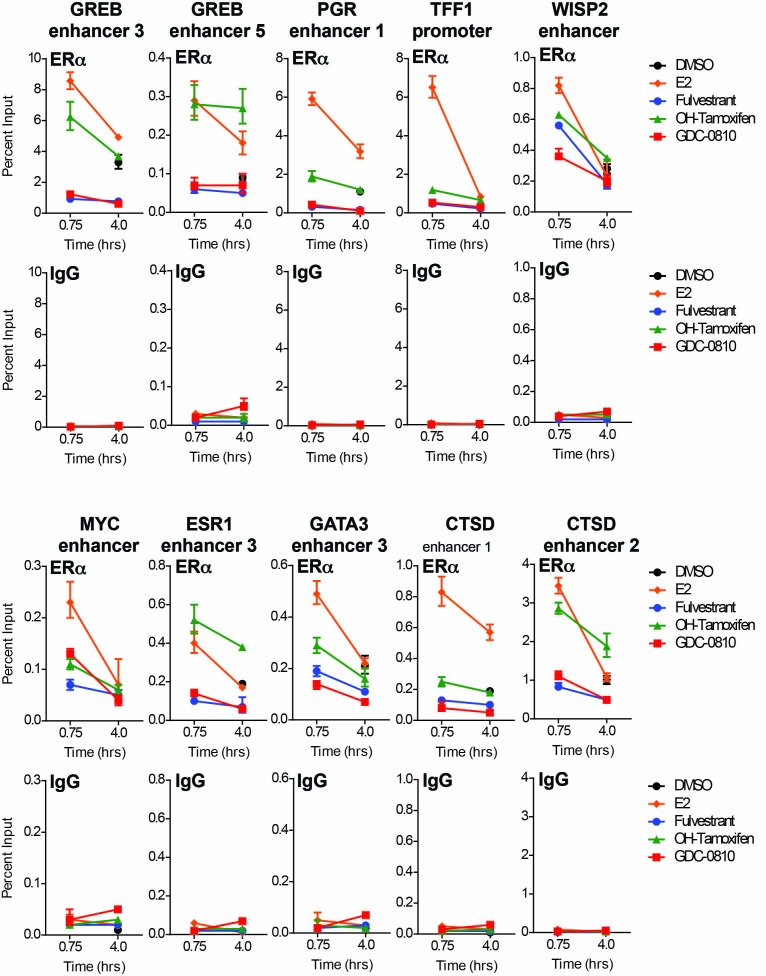
GDC-0810 does not promote the binding of ERα to known ER target sites.ERα ChIP was performed on MCF7 cells following 45 min or 4 hr compound incubation. qPCR quantification was performed using oligonsucleotides directed to 10 distinct ERα binding sites. Data for ERα and non-specific IgG control is plotted as a percent of total input.